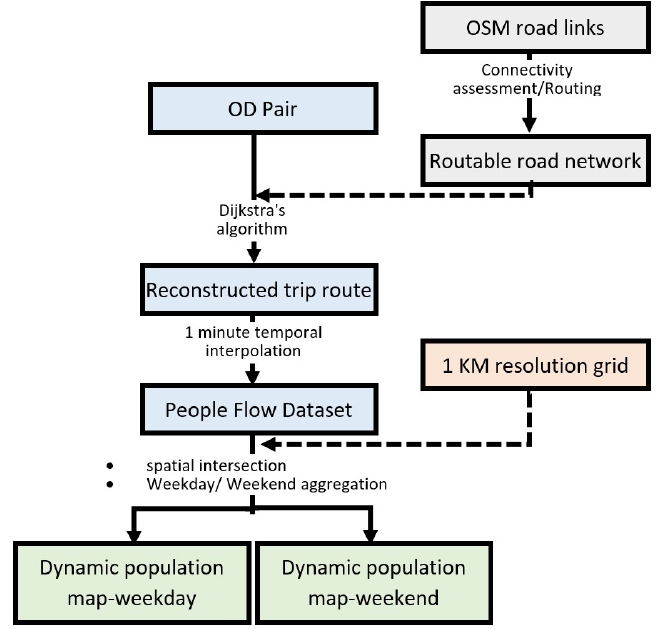
Figure 12. Spatiotemporal interpolation method to derive population distribution.